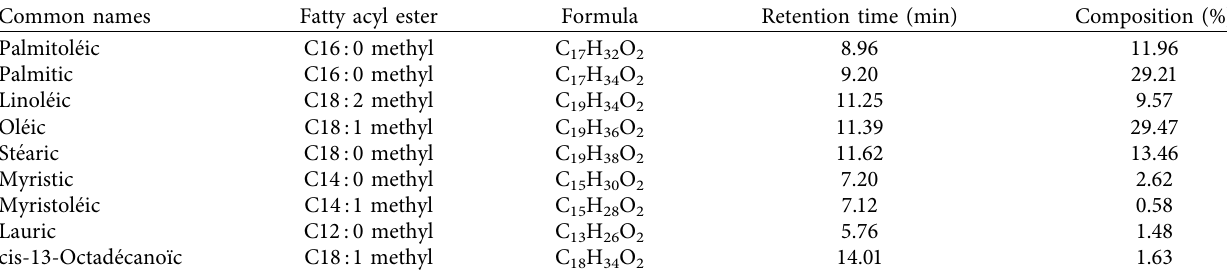
Figure 4: Spectrum of methyl esters present in the EMHP Table 4: Methyl fatty acid esters identified in biodiesel